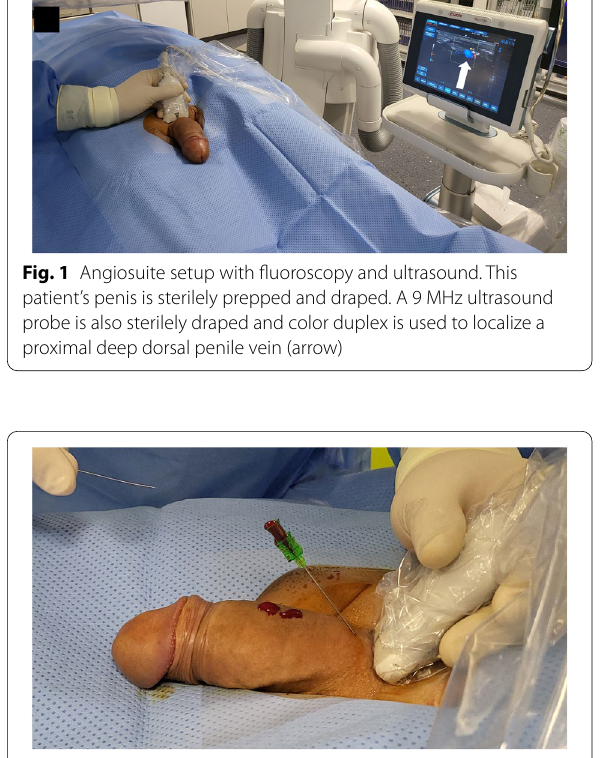
Fig. 2 After subcutaneous administration of lidocaine 2% for local anesthesia and light sedation, ultrasound-guided puncture of a deep dorsal penile vein is performed using a 21-G micropuncture needle (Cook, U.S.A.). The needle is slowly advanced until blood returns from the needle hub (ref. corresponding movie file)